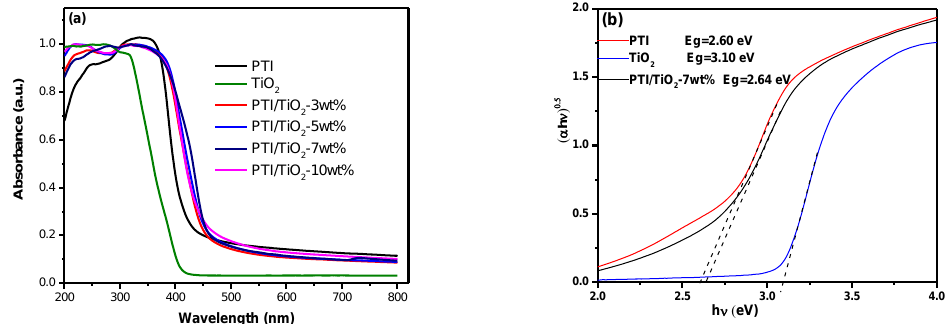
Figure 3. ( a ) UV–vis diffuse reflectance spectrum (DRS) of PTI, TiO 2 and PTI/TiO 2 heterojunction with different TiO 2 content. ( b ) estimated band gap energies of PTI, TiO 2 and PTI/TiO 2 -7 wt%